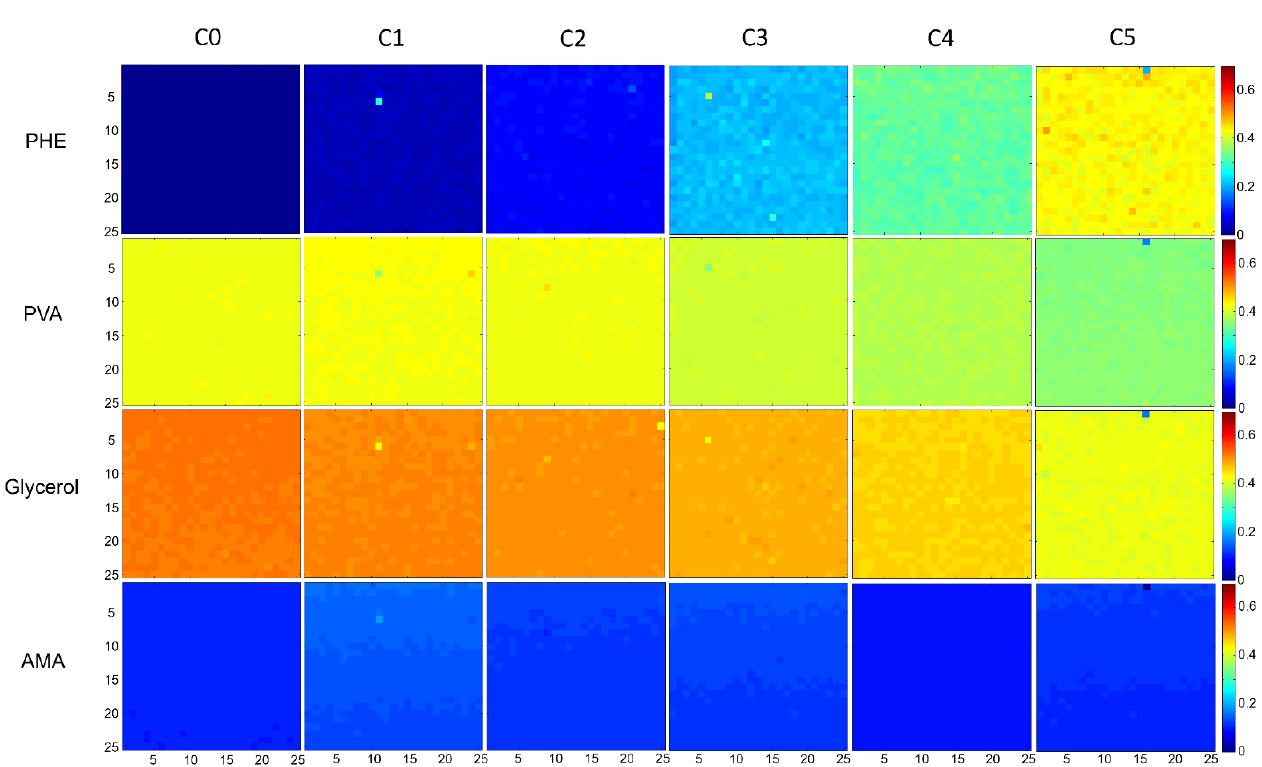
Figure 7. Typical reconstructed non-negatively constrained least squares (NCLS) maps following analysis of PVA-GS films loaded with increasing concentration of PHE: C0 , C1 , C2 , C3 , C4 , and C5 . The scale bar represents the contribution of each component spectrum in the Raman spectra at each pixel.